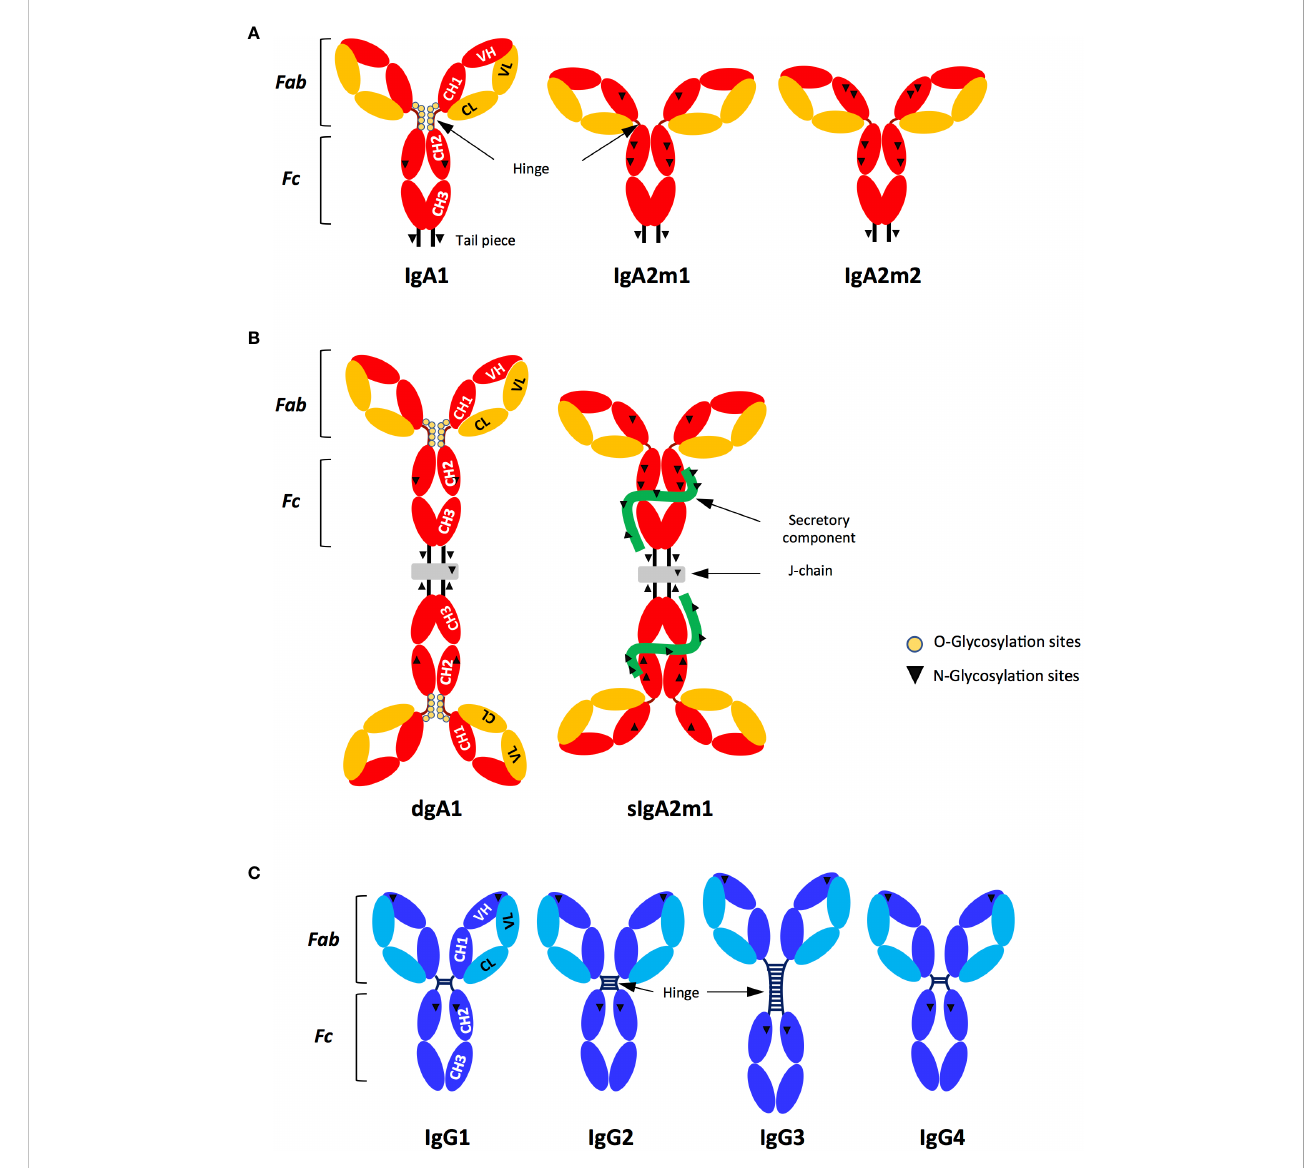
FIGURE 1 Structure and subtypes of IgG and IgA. (A) Monomeric IgA (IgA1, A2m1, IgA2m2); (B) Dimeric IgA (dIgA1) and secretory IgA (sIgA2m1). (C) IgG (IgG1, IgG2, IgG3, IgG4). The IgA (A, B) and IgG (C) isotypes contain two functional parts: the Fab formed by the entire light chain (VL-CL) and the fi rst two domains of the heavy chain (VH-CH1) while the Fc is formed by the CH2 and CH3 domains located in the constant heavy chains. The VH and VL sequences represent the variable regions of the heavy and light chains (HC and LC respectively), together forming the antigen-speci fi c paratope. The J chain (grey) is present in dimeric and secretory IgA (dIgA and sIgA, respectively). SIgA contains the secretory component (green), which corresponds to the extracellular region of pIgR acquired by proteolytic cleavage, after pIgR had translocated dimeric IgA to mucosal surfaces (B) . Inverted triangles and yellow circles represent the N- and O-glycosylation sites, respectively (A, B and C). Hinge length varies between human IgA and IgG subtypes: (A, B) IgA1>IgA2; (C) IgG3>IgG2>IgG1 and